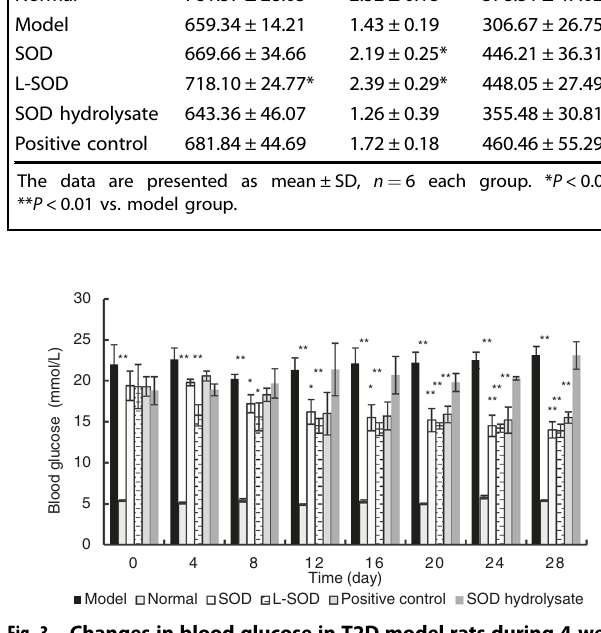
Fig. 3 Changes in blood glucose in T2D model rats during 4-week intervention. The data are presented as mean ± SD, n = 6 each group. * P < 0.05, ** P < 0.01 vs. model